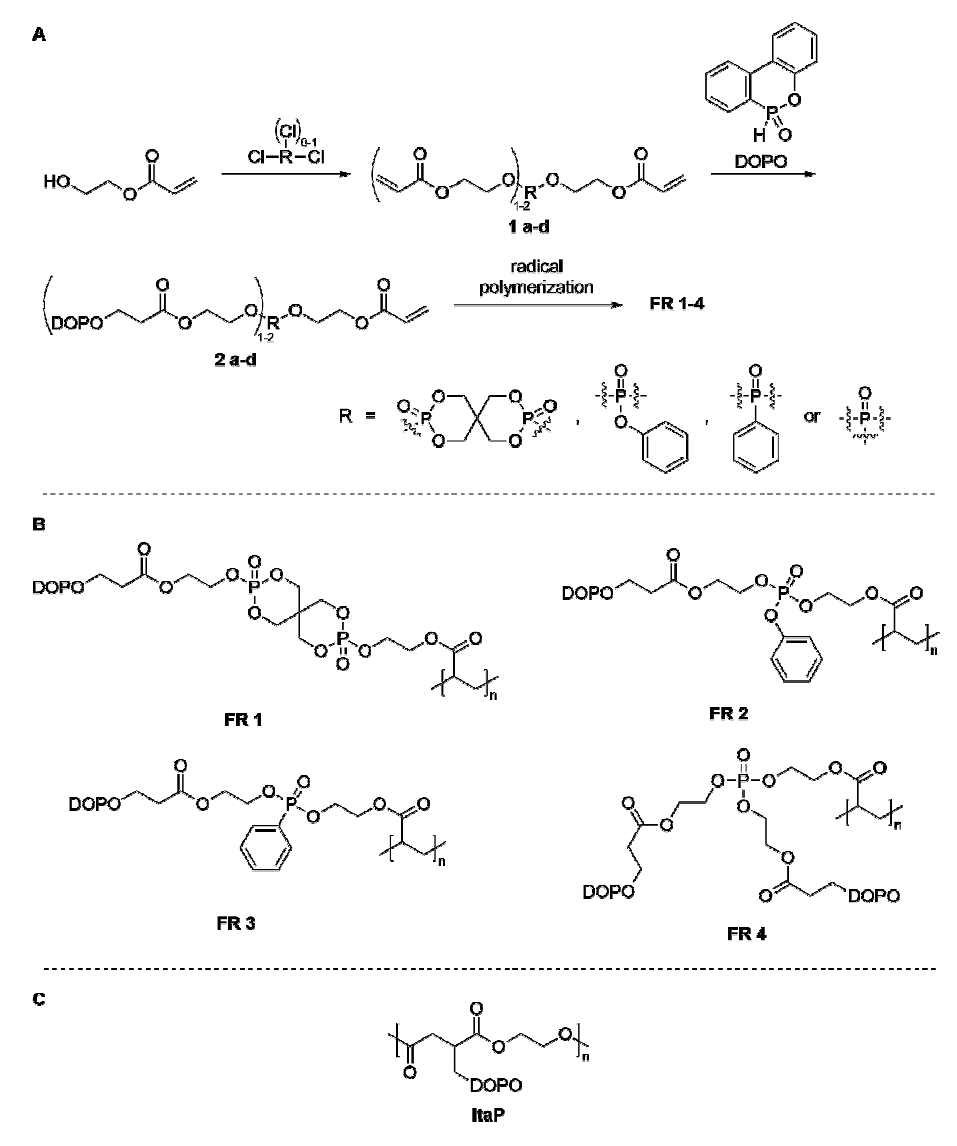
Figure 1. Synthesis route to flame retardant (FR) 1–4 ( A ), full structure of FR 1–4 ( B ) and structure of a flame retardant polyester containing only one phosphorus group (ItaP) ( C ).